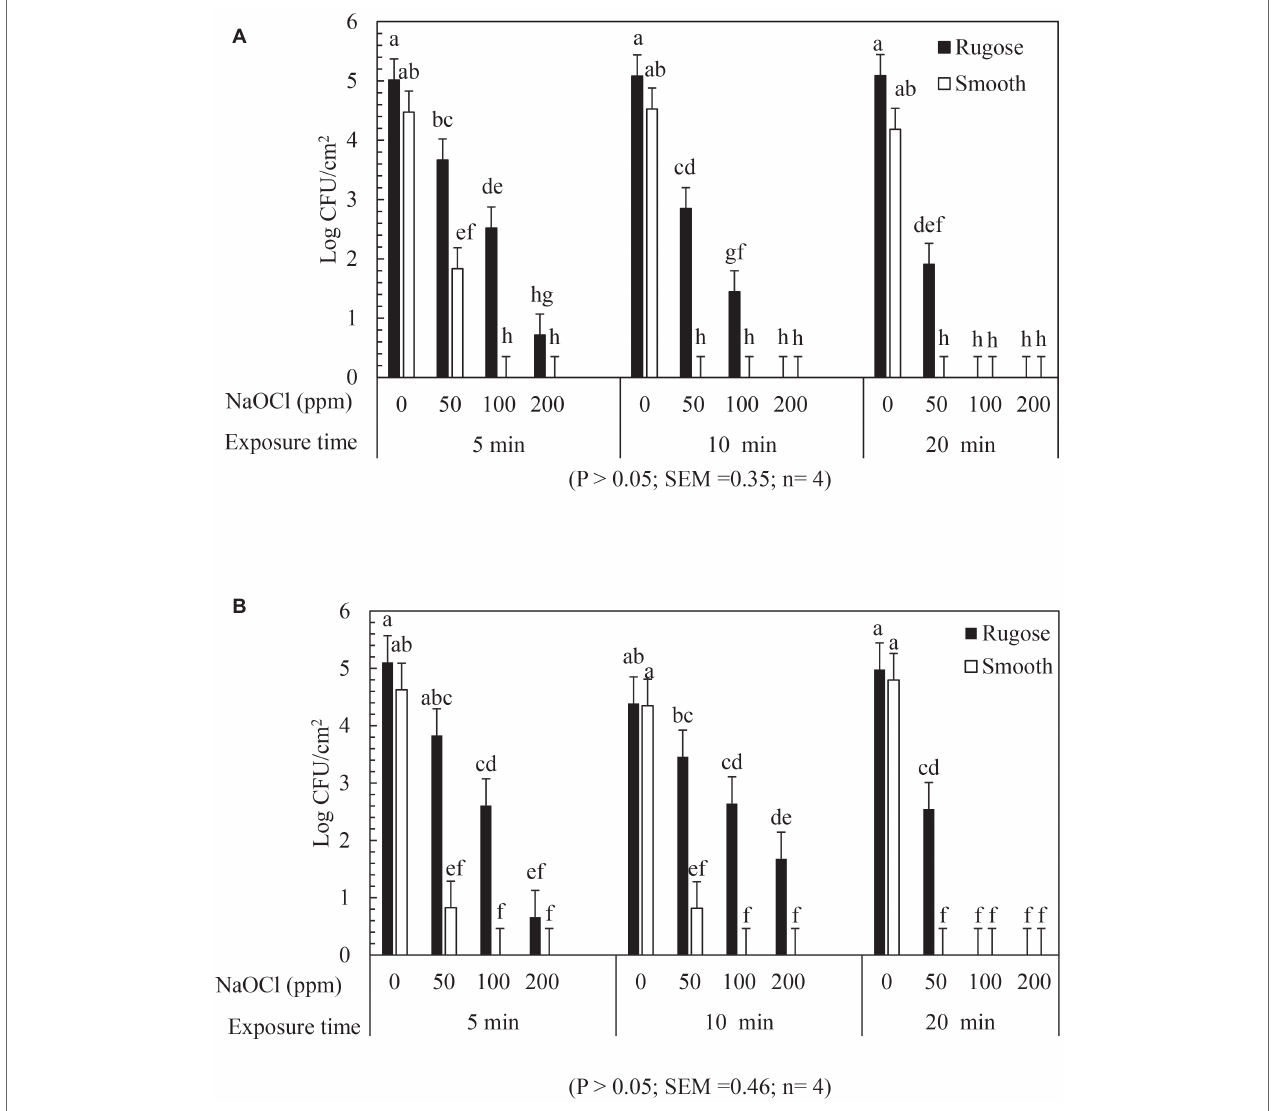
FIGURE 5 | Biofilm survival of S. Typhimurium ATCC 14028 and S. Heidelberg ATCC 8326 morphotypes on stainless steel surface after NaOCl treatment. Bars represents S. Typhimurium (A) and S. Heidelberg (B) biofilm survival at different NaOCl concentrations (50, 100 or 200 ppm in water) for different exposure times (5, 10, or 20